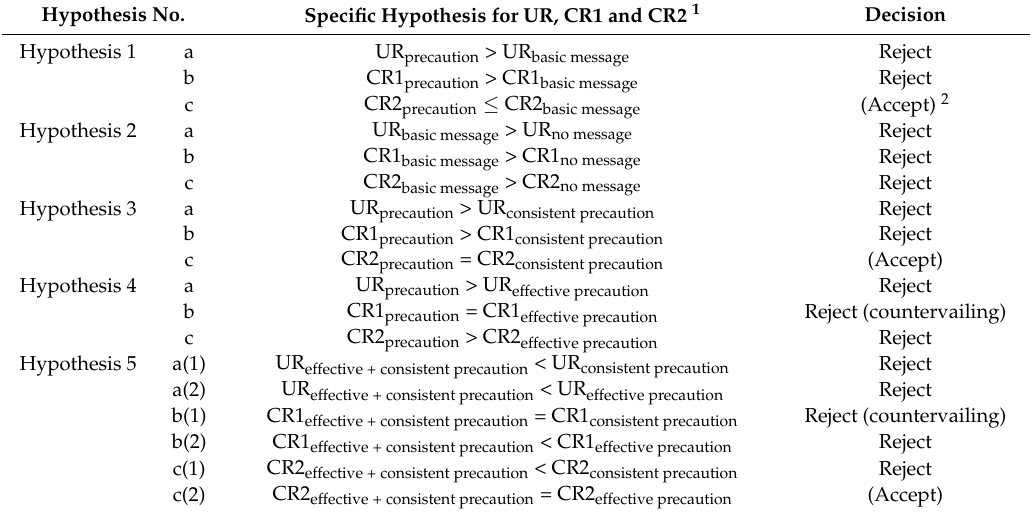
Table 5. Summary of hypotheses